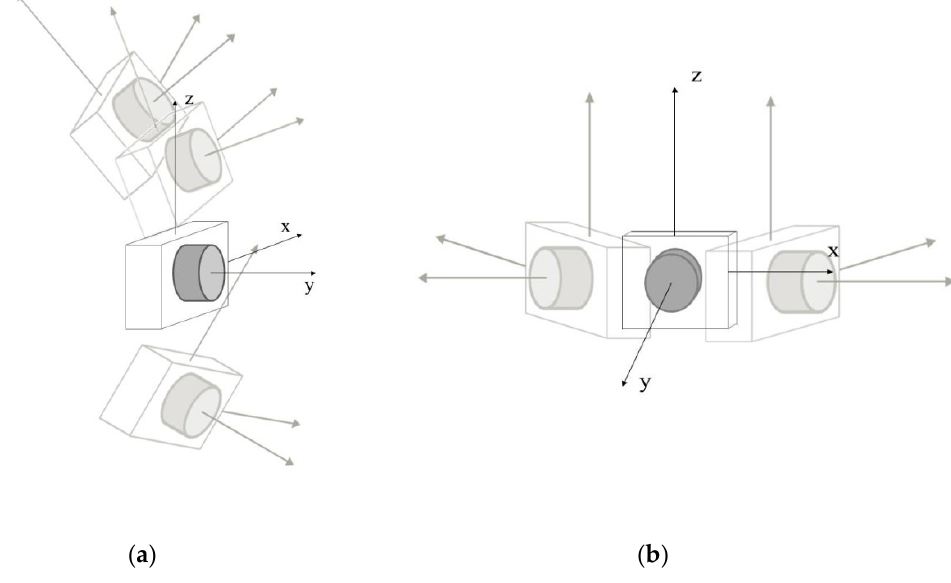
Figure 4. Divergent self-rotation in the ( a ) X -axis; and ( b ) Z -axis.